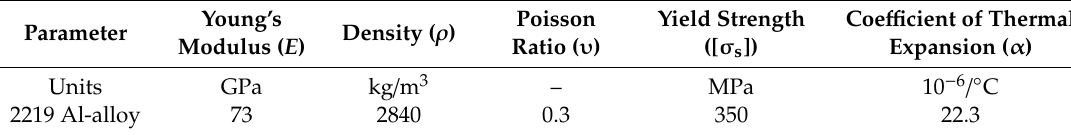
Table 1. Physical properties of 2219 aluminum alloy.